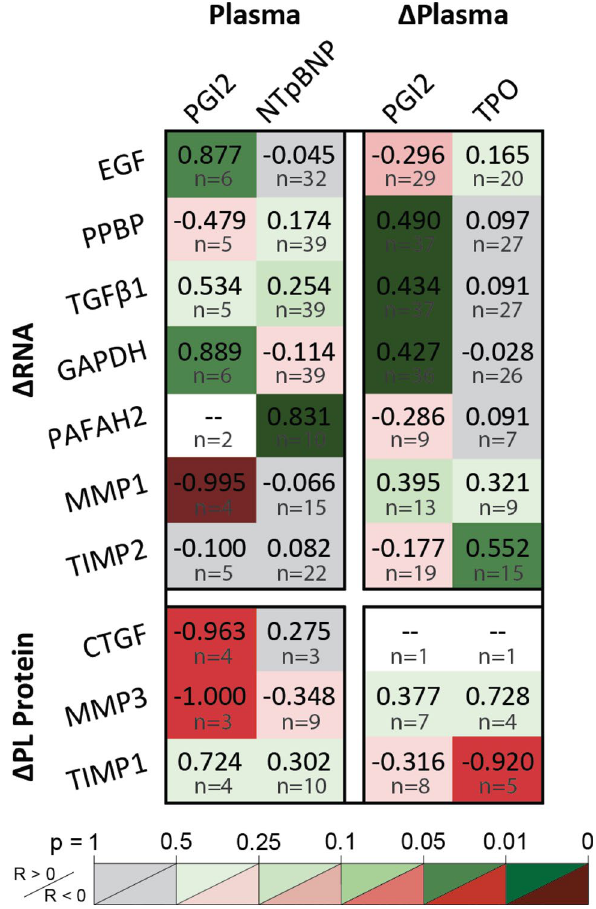
Figure 5. Cardiovascular stress markers indicated platelet dysfunction. Platelet inhibition by PGI 2 protects RNA from translation as shown by positive correlations against EGF, GAPDH, PPBP, and TGFβ1 transcripts and negative correlations against granule CTGF and MMP3. PAFAH2 upregulation correlates to plasma NTpBNP, showing platelet dysfunction with chronic cardiac strain. Platelet renewal is shown by TIMP2 RNA increases and granule TIMP1 decreases with plasma TPO. Figure was prepared in Microsoft Excel v2020 (Microsoft Corp. www. micro soft.